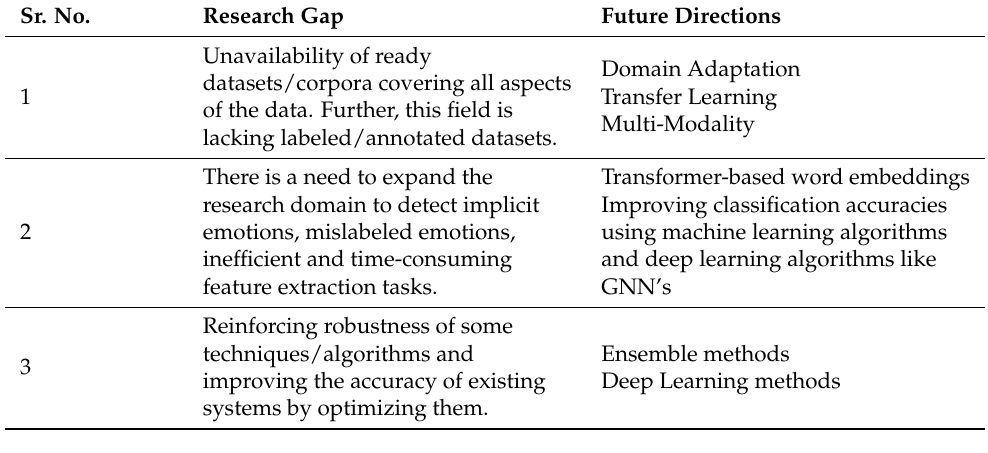
Table 25. Summary of research gaps with future directions.